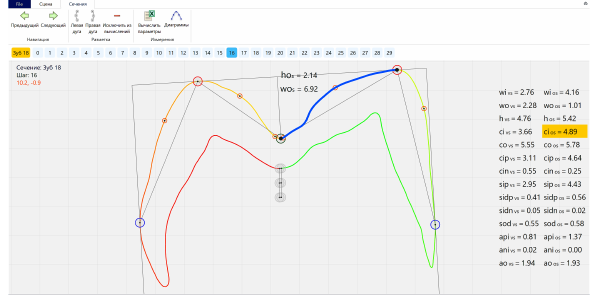
Figure 4. Measurements on the enamel cap